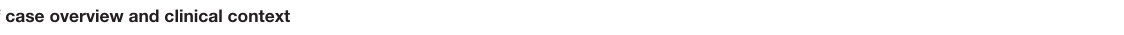
TABLE 1 | Example of ACT processes in an open